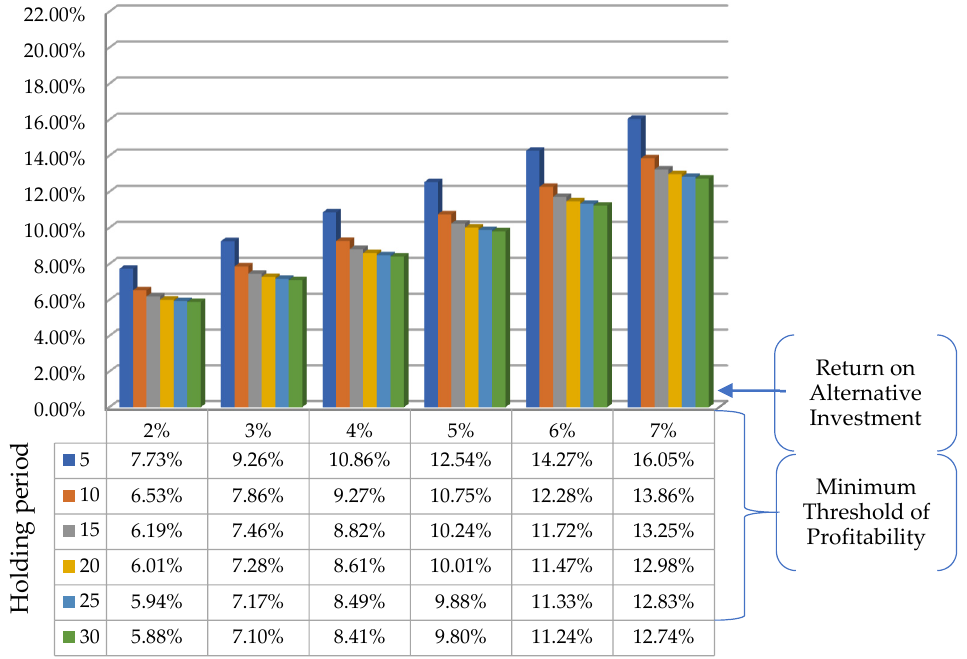
Figure 7. Distribution of the Pmt , depending on the holding period and return on alternative investment (case